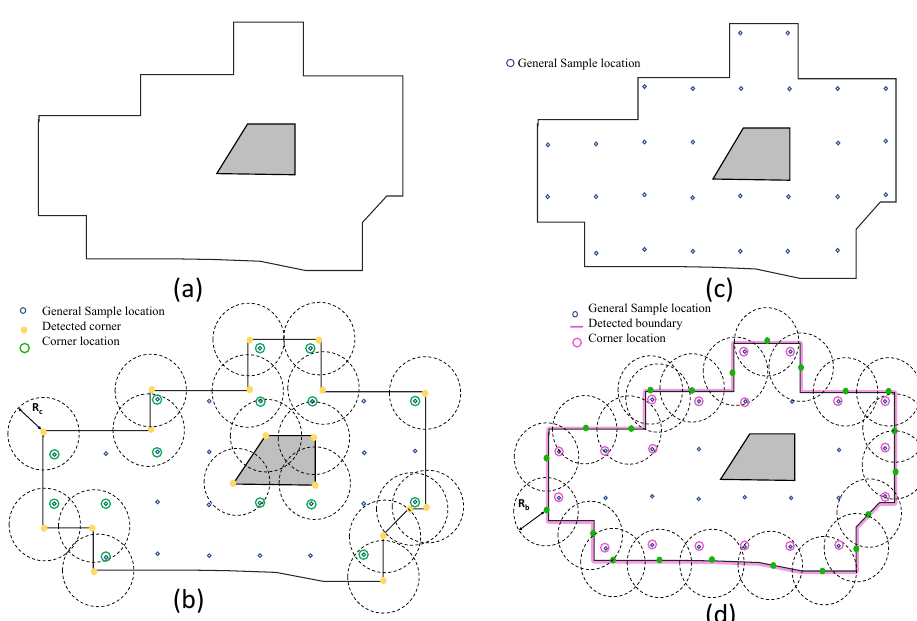
Figure 3. The representation of occupancy grid ( a ), corner location extraction ( b ), general sample locations after uniform sampling ( c ), and boundary location extraction ( d